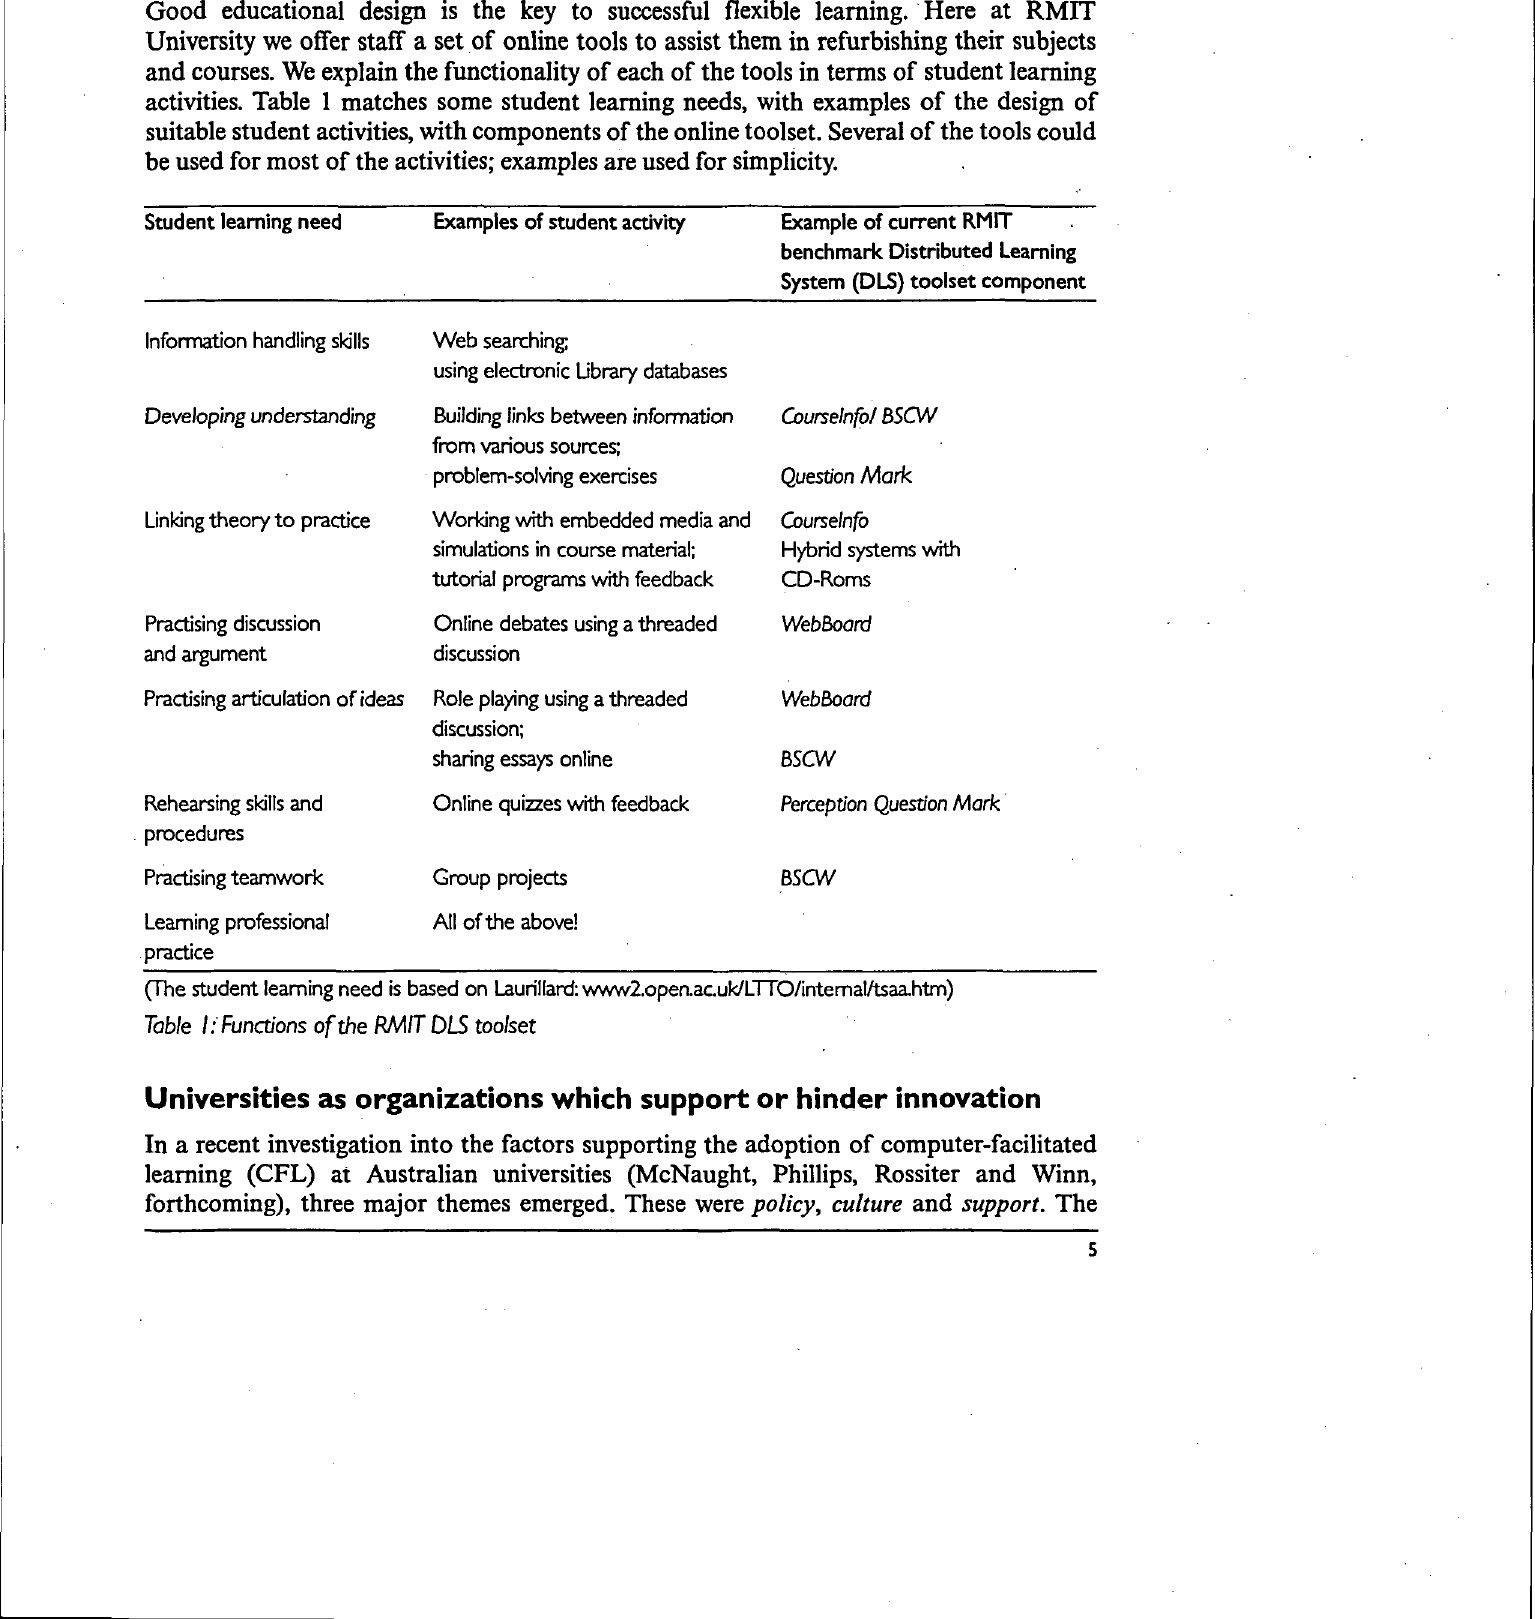
Table I: Functions of the RMIT DLS